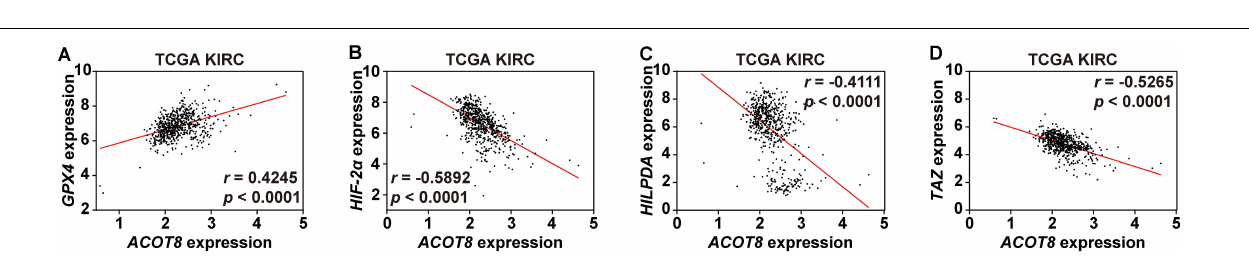
FIGURE 8 | ACOT8 is correlated with ferroptosis-related genes in ccRCC. Correlation between ACOT8 and four ferroptosis-related genes in ccRCC was analyzed using TCGA KIRC dataset (A–D)